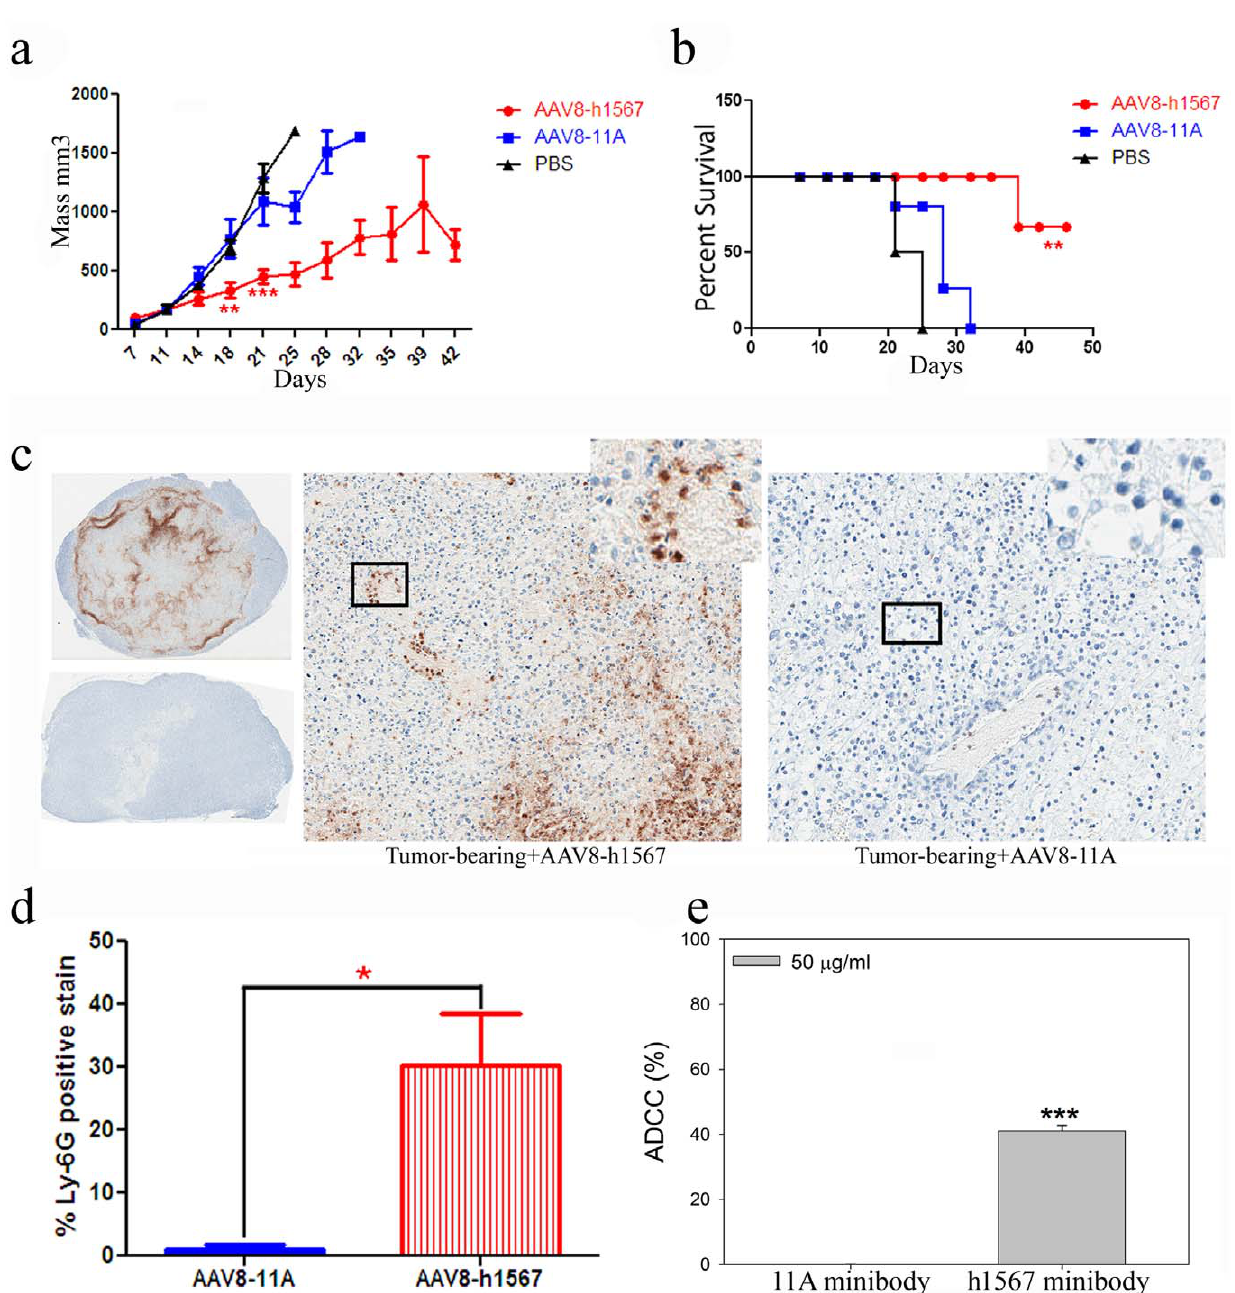
Figure 2. Anti-tumor effect of AAV8-derived h1567 minibody. ( a ) The tumor volume of each individual tumor plotted as a function of times (days post inoculation). AAV vectors were delivered intravenously by tail vein injection 7 days after the inoculation of 2.5 6 10 6 Mac-1 tumor cells. **P , 0.01, ***P , 0.0005 when comparing tumor mass in AAV8-h1567-treated and control vector AAV8-11A-treated group on Day 18 and Day 21, respectively. ( b ) Survival analysis of AAV8-h1567 or control AAV8-11A-treated tumor-bearing mice (engrafted with 2.5 6 10 6 Mac-1 tumor cells). Tumor-bearing PBS-treated mice were used as background controls. Statistically significant difference was observed between 1567 minibody-treated group and control groups (P , 0.01). ( c ) Immunohistochemical analysis of representative tumor sections with anti-Ly-6G, a specific mAb recognizing murine neutrophils. The immunostaining shows tumor-infiltrating neutrophils (brown stain) in tumor from the SCID-BEIGE mice 21 days after administration of AAV8-h1567 encoding anti-CCR4 minibody (upper-left for entire tumor section and center-panel for magnified section). No staining was seen in the tumor from the mice treated with control vector AAV8-11A (lower-left and right panel). ( d ) Quantification of neutrophil infiltration from panel C. Entire tumor sections were captured using the Aperio ImageScope instrument, and the percentage of positively stained cells were quantitated by using a color deconvolution algorithm. *P , 0.05. ( e ) In vitro ADCC activity against Mac-1 cells in the presence of h1567 minibody. The ADCC activity was assessed using purified SCID-BEIGE neutrophils as effector cells and CCR4 + Mac-1 cells as target cells. Neutrophil-mediated lysis of target cells was induced at an E:T ratio of 80:1 in the presence of 50 ug/ml purified h1567 minobodies. The figure shown is representative of three independent experiments. *P , 0.05, **P , 0.01, ***P , 0.0005. All data are represented as the mean 6 SD.